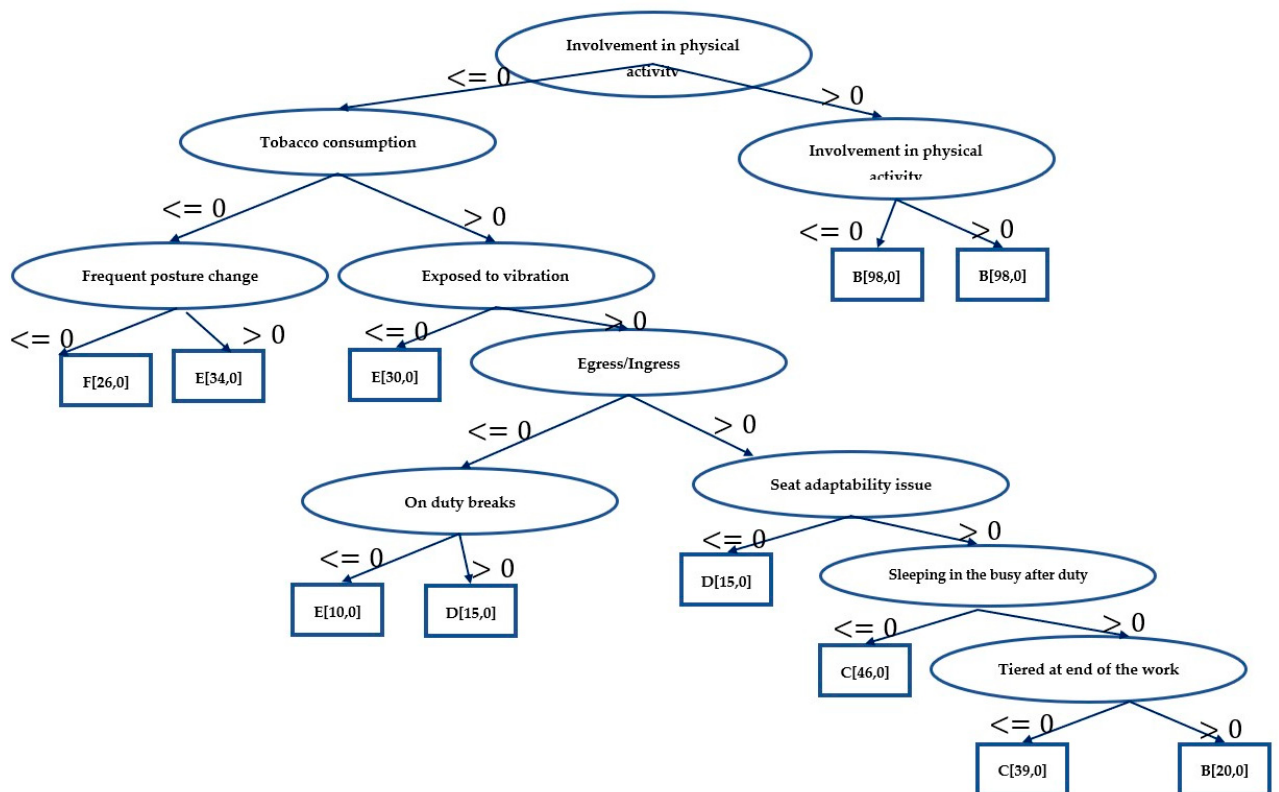
Figure 1. Decision tree model. Table 1. Classification result for decision tree.